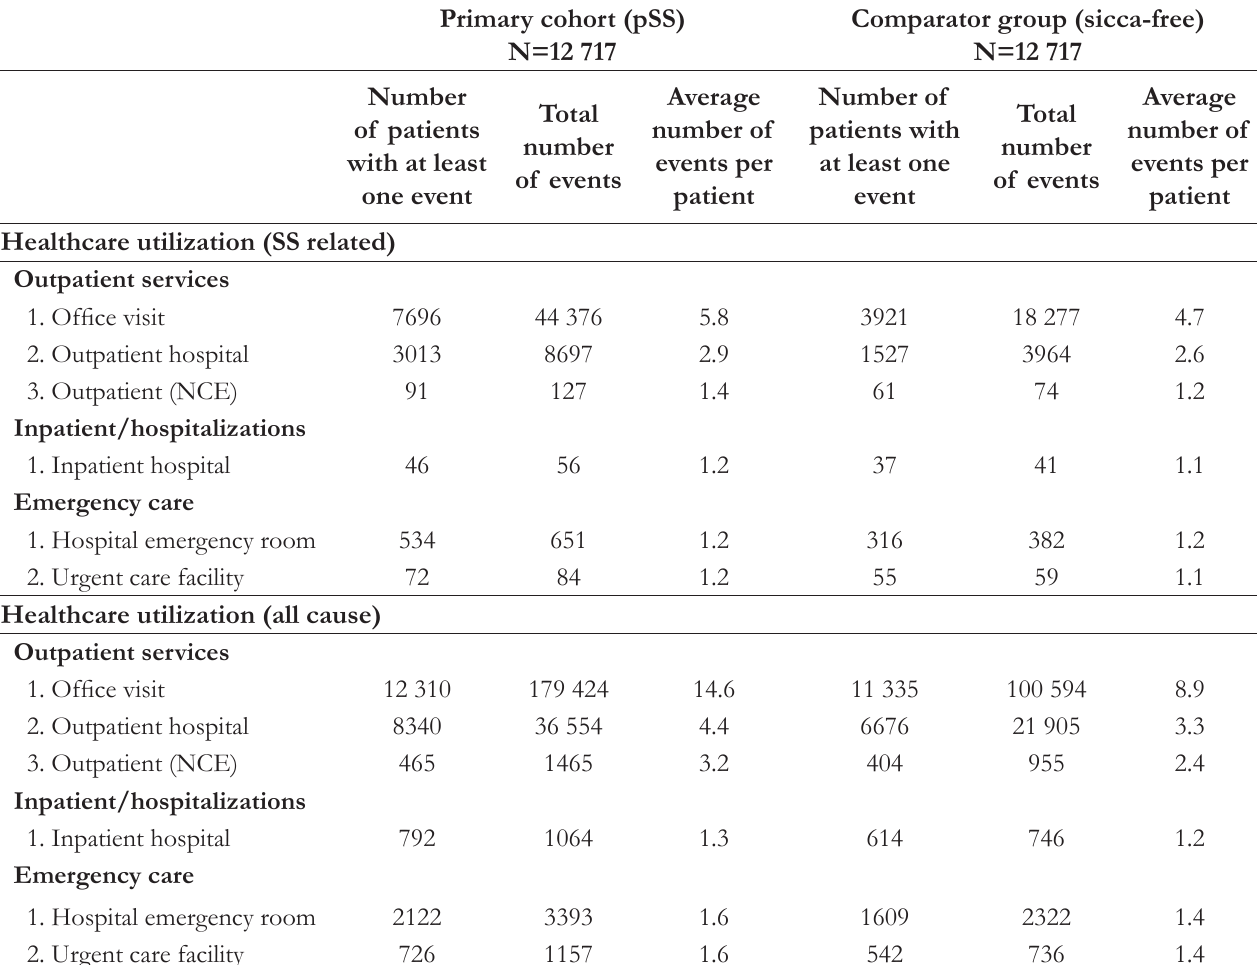
Table 2. Healthcare Resource Utilization in the Primary Cohort and Comparator Group